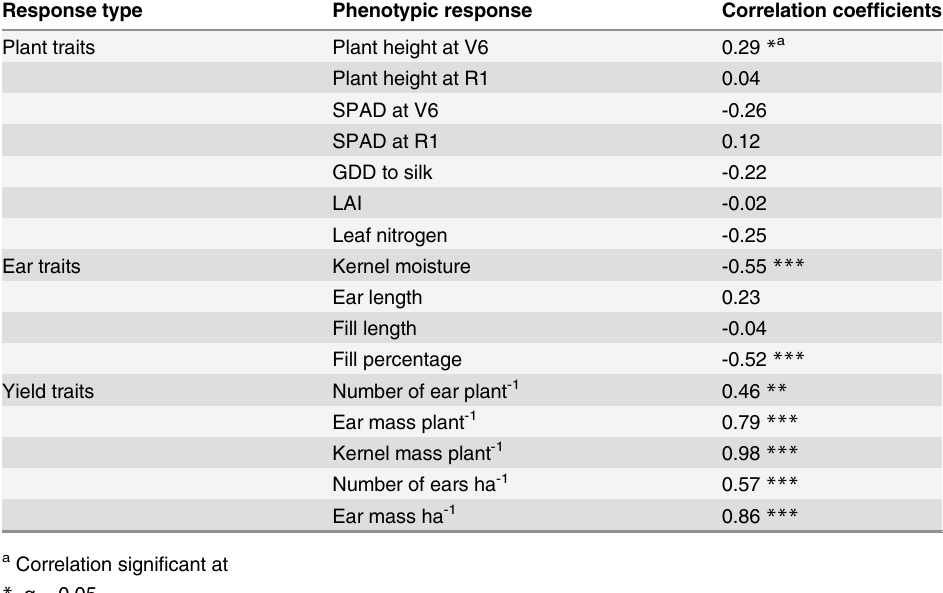
Table 3. Correlation coefficients between phenotypic responses and kernel mass per